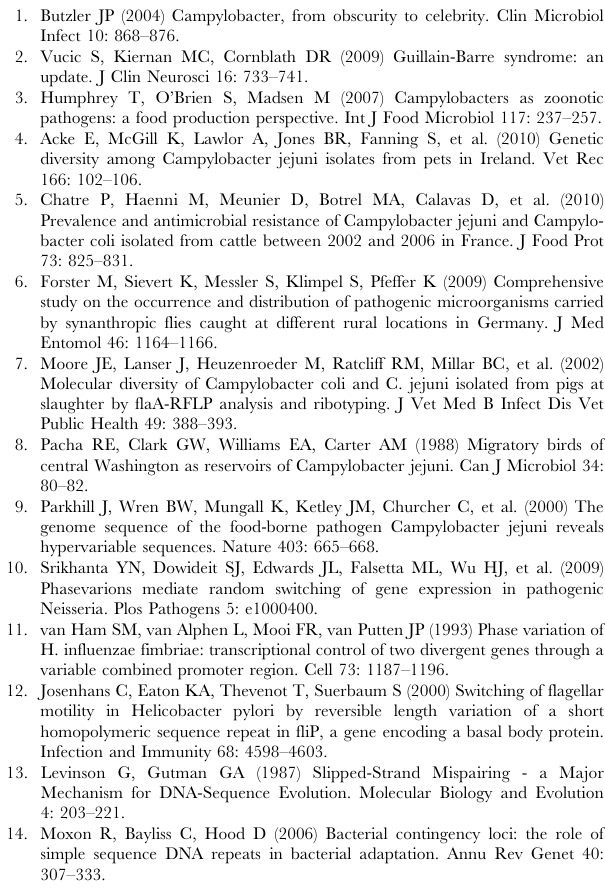
Table S1 SNP changes during passage. All detected SNPs that changed frequency in the population by 5% or more are shown. Verification of SNPs was through traditional sequencing of PCR products to observe a mixed peak at the relevant nucleotide position.